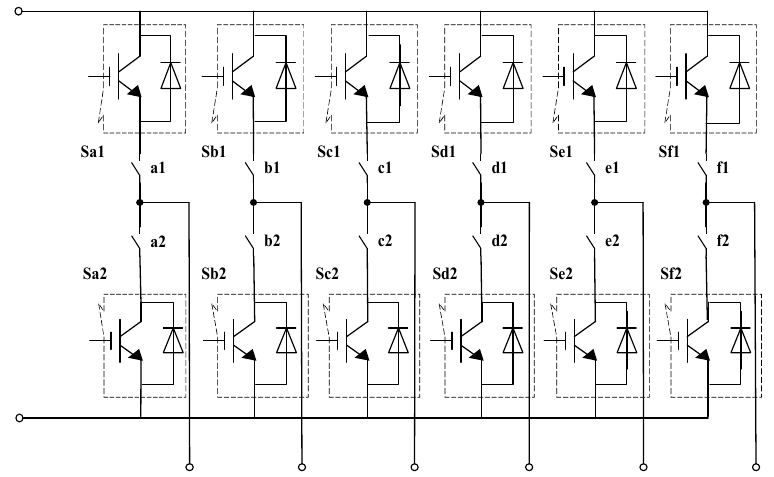
Figure 4. The topology of six ‐ phase converter with isolation function.